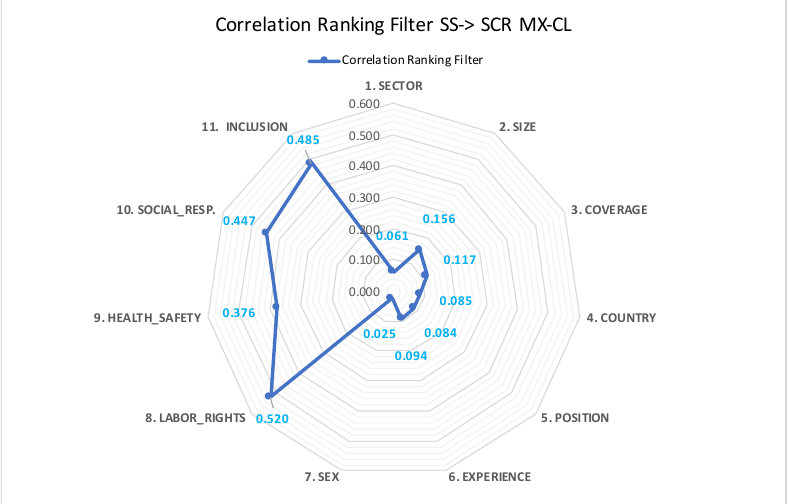
Figure 4. Ranking of the Pearson correlation coefficient for Mexico’s and Chile’s